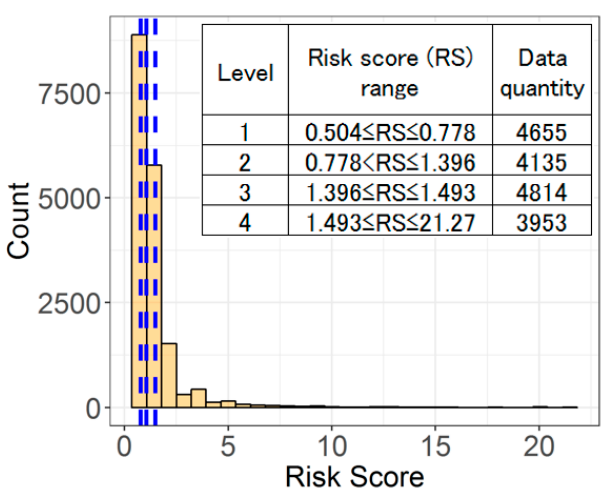
Figure 10. Risk score distribution in East Japan. Appl. Sci. 2018 , 8 , x FOR PEER REVIEW